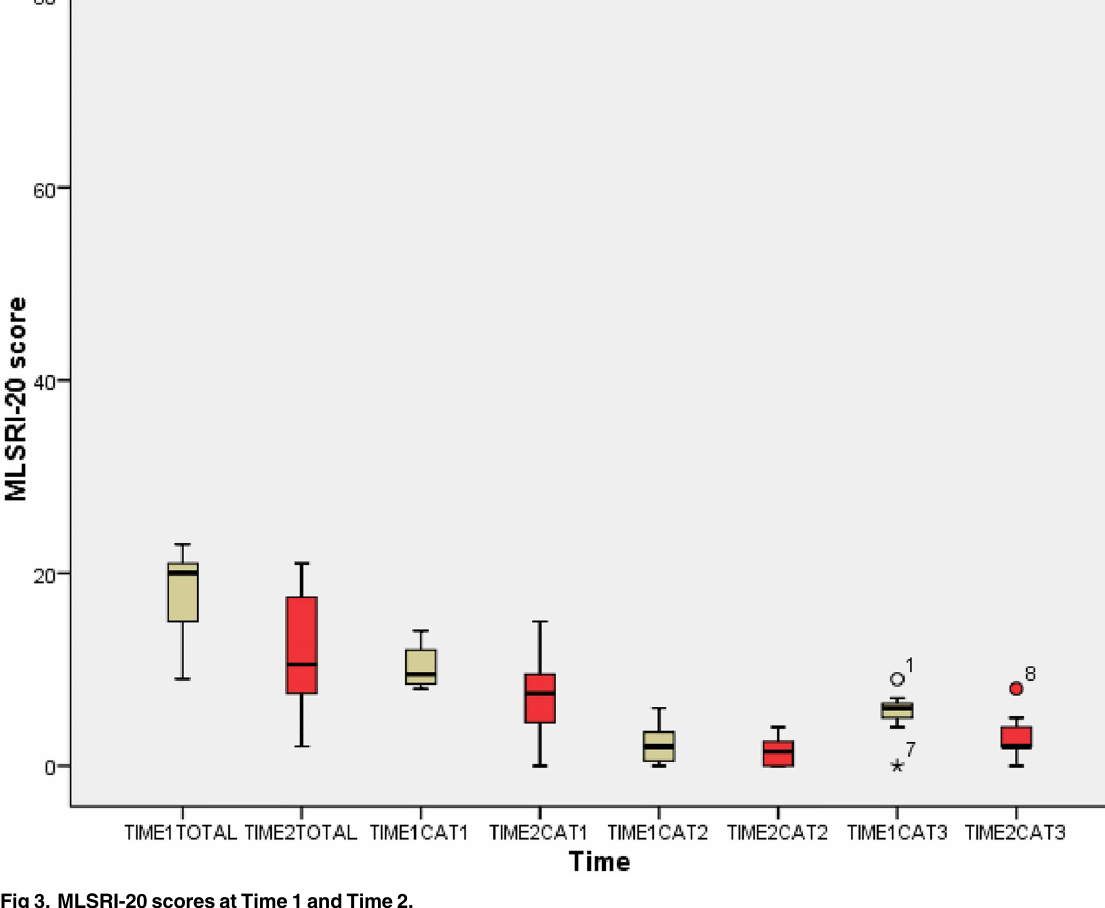
Fig 3. MLSRI-20 scores at Time 1 and Time